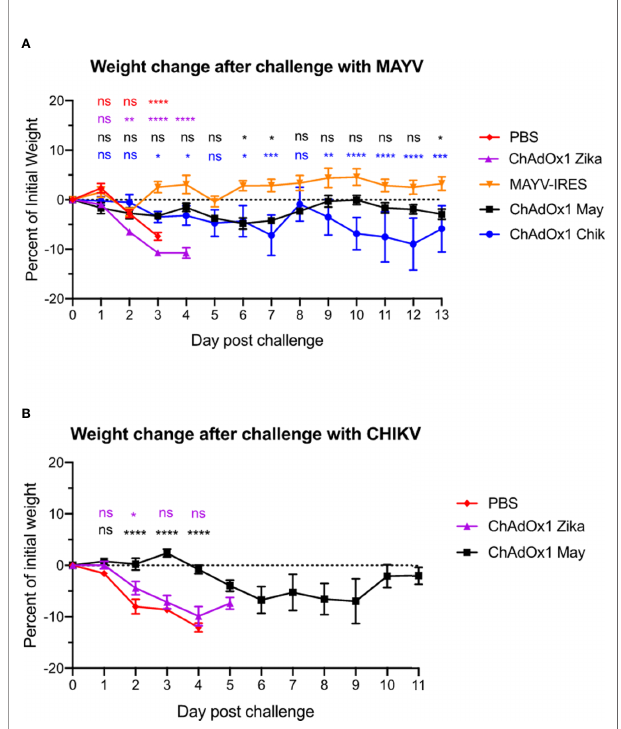
FIGURE 3 | ChAdOx1 May and ChAdOx1 Chik vaccination protect against weight loss. Animals were challenged thirty days post-vaccinations with Mayaro virus (MAYV) or chikungunya virus (CHIKV) (backtiters 1.6 and 9.7 x 10 4 PFU/mouse). (A) Weight change in vaccinated mice after challenge with MAYV. Data represented as mean and SEM, restricted maximum likelihood mixed model with Dunnett ’ s (compared with MAYV-IRES group). (B) Weight change in vaccinated mice after challenge with CHIKV. Data represented as mean and SEM, restricted maximum likelihood mixed model with Dunnett ’ s (compared with PBS group) *p < 0.05, **p < 0.01, ***p < 0.001, ****p < 0.0001. ns, not signi fi